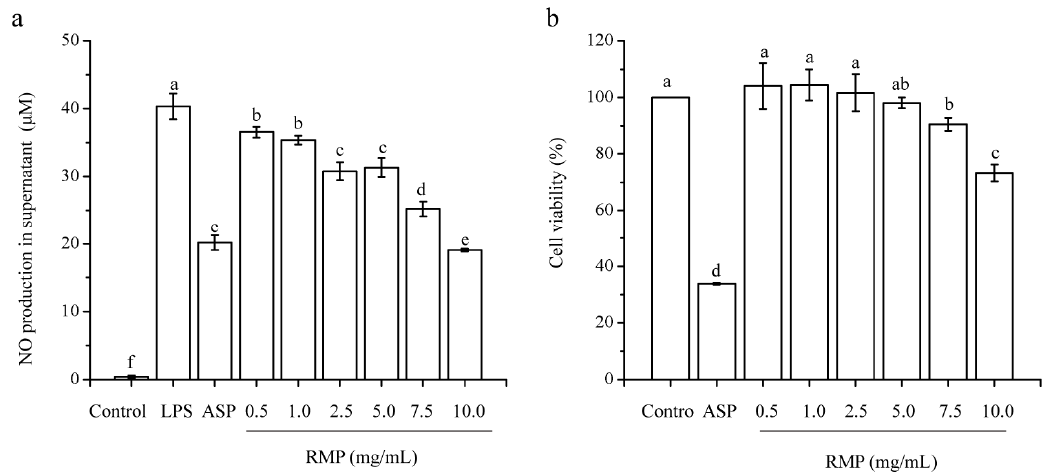
Figure 5. Anti-inflammatory activity of RMPs. ( a ) Effect of RMPs on inhibiting NO production and ( b ) the cell viability of RAW 264.7 cells. Abbreviations: LPS, lipopolysaccharides; ASP, aspirin. Different letters (a-f) indicate significant difference between groups ( P < 0.05) and same letters indicate P > 0.05 . Table 4. Anti ‐ inflammatory activity of RMPs.